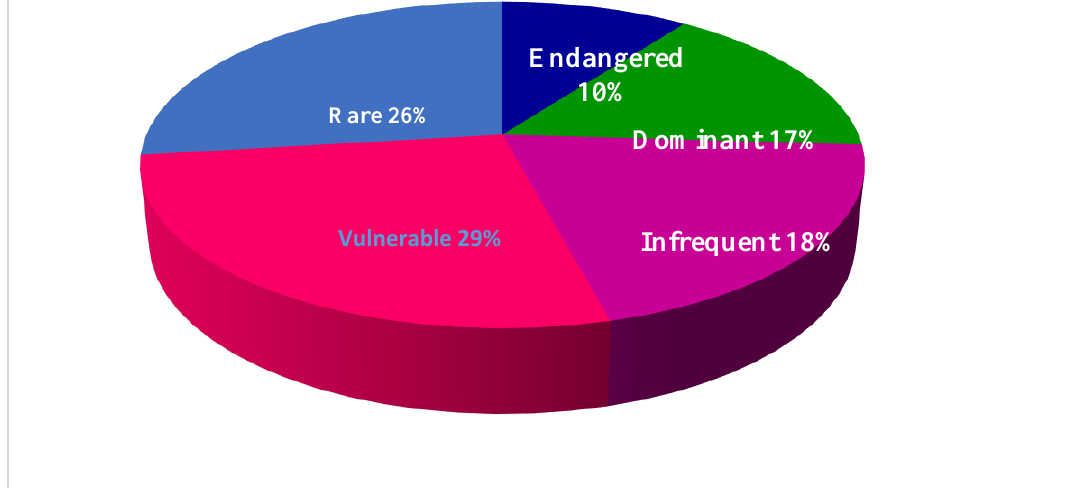
Figure 5. Conservation status of medicinal plants.